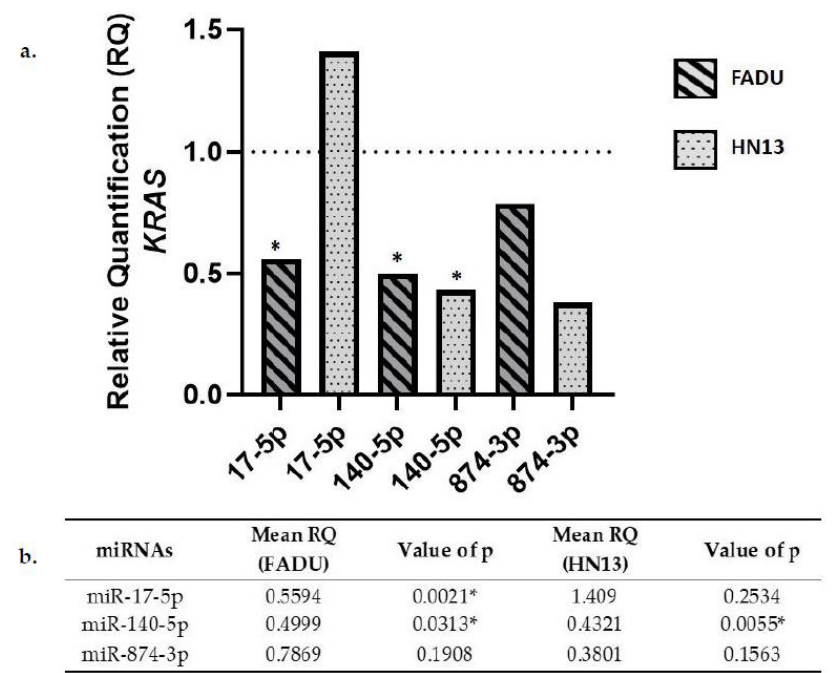
Figure 3. ( a ) KRAS gene expression after miR-17-5p, miR-140-5p and miR-874-3p transfection com- pared to the negative control (RQ = 1). ( b ) Mean relative quantification (RQ) of KRAS gene expression in HNC cell lines transfected with miR-17-5p, miR-140-5p, and miR-874-3p. * Significant values. 2.5. NFE2L2 Gene Expression in Transfected Cells NFE2L2 expression was downregulated in both cell lines after transfection with miR- 17-5p and miR-140-5p. On the other hand, NFE2L2 expression was upregulated in FADU cells transfected with miR-874-3p. The same was not observed for HN13 cell lines, which showed a downregulation of NFE2L2 after miR-874-3p transfection (Figure 4).